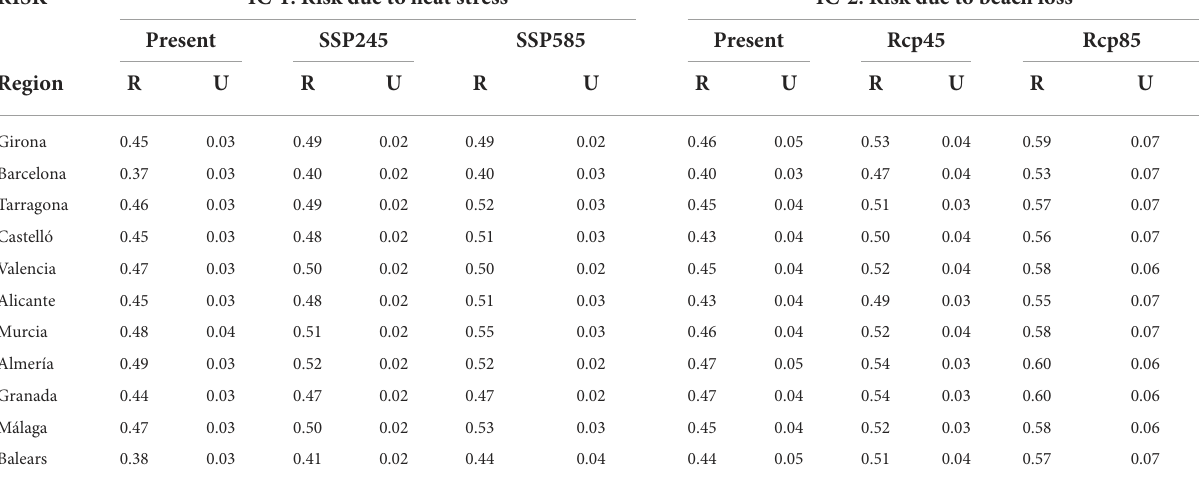
TABLE 4 Final risk (R) and uncertainties (U) for each province (in rows) and for the two study cases, IC-1 and IC-2 for the present climate and under GHG scenarios (columns). RISK IC-1: Risk due to heat stress IC-2: Risk due to beach loss Present SSP245 SSP585 Present Rcp45